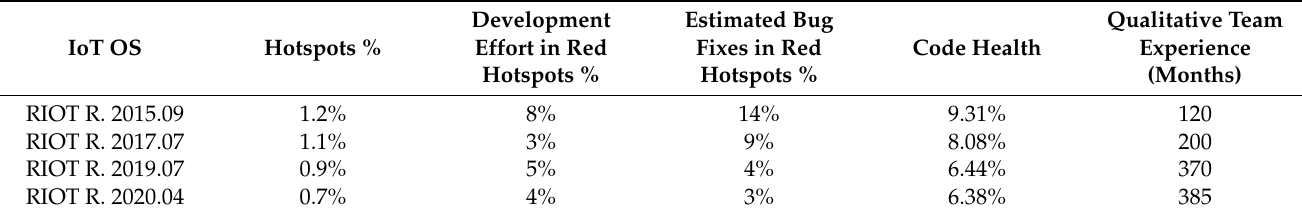
Table 11. CodeScene analysis results for RIOT.